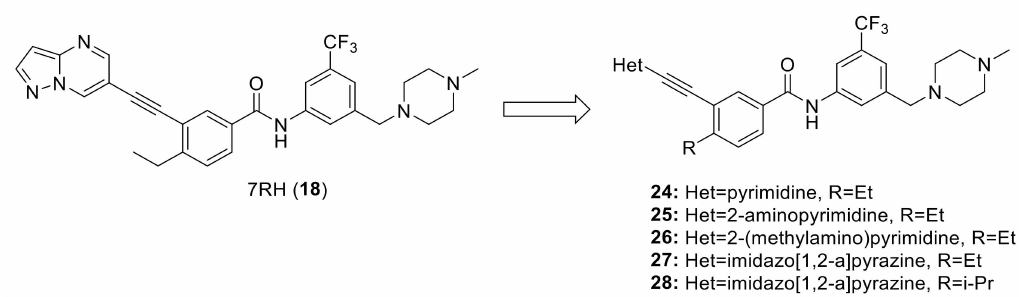
Figure 9. Chemical structures of compound 24 – 28 designed based on 7RH ( 18 ) as a lead